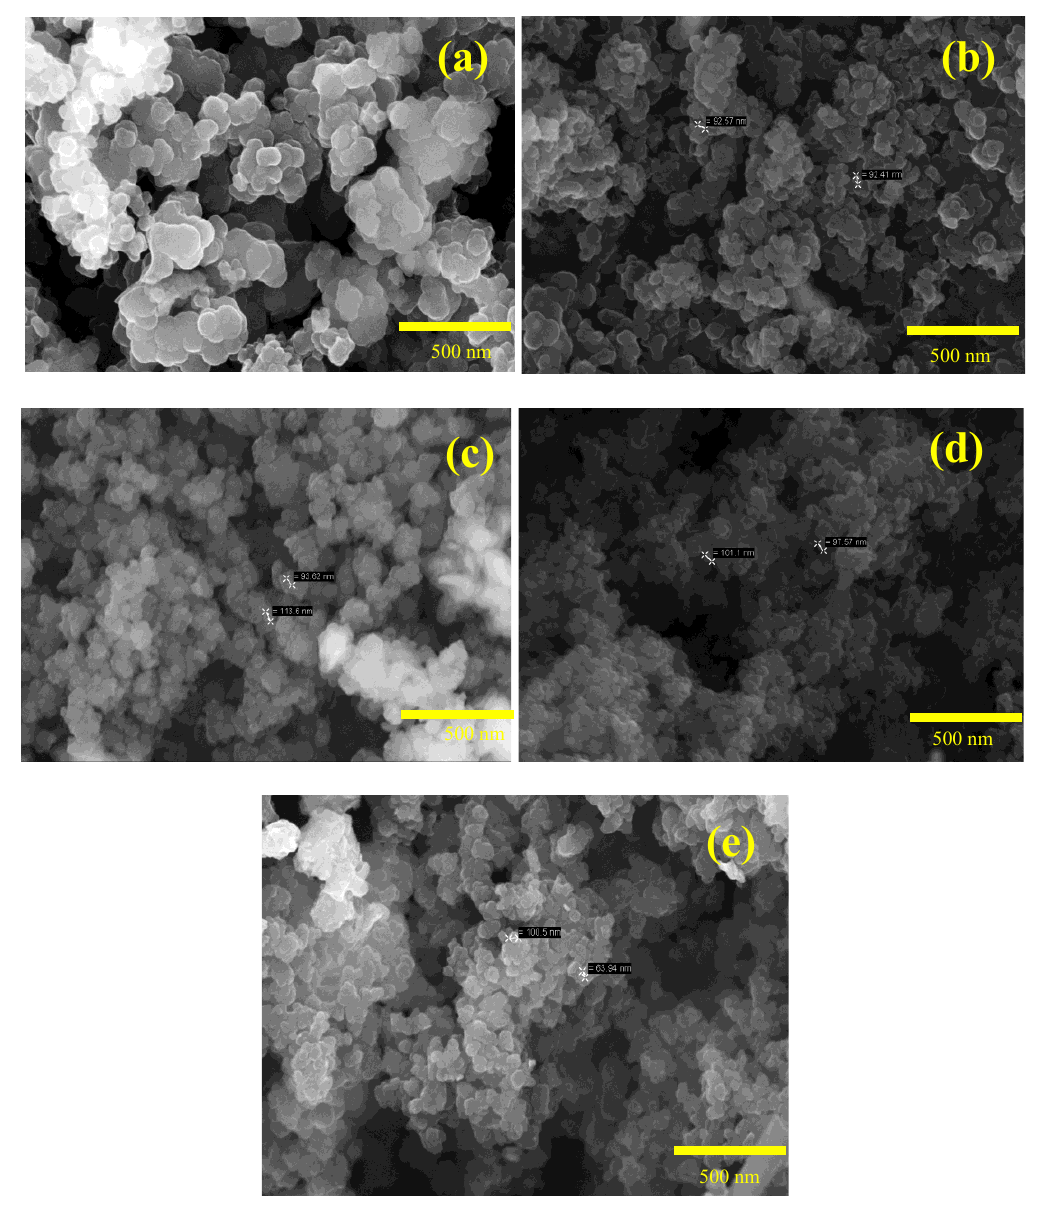
Fig. 2. FE-SEM images of pure PPy (a) and NiO-PPy (b-e)